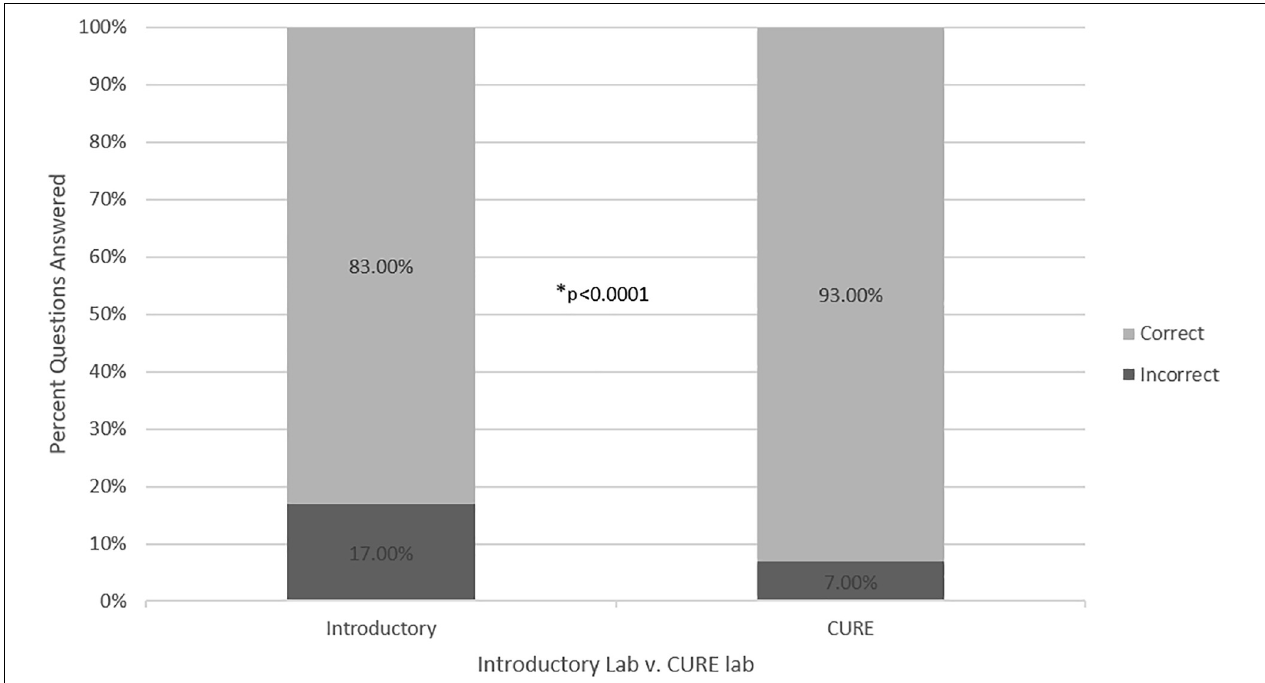
FIGURE 2 | Correct answers. Comparison of the proportion of correct answers per each Thought Question attempt after the introductory and CURE labs. * p < 0.0001.